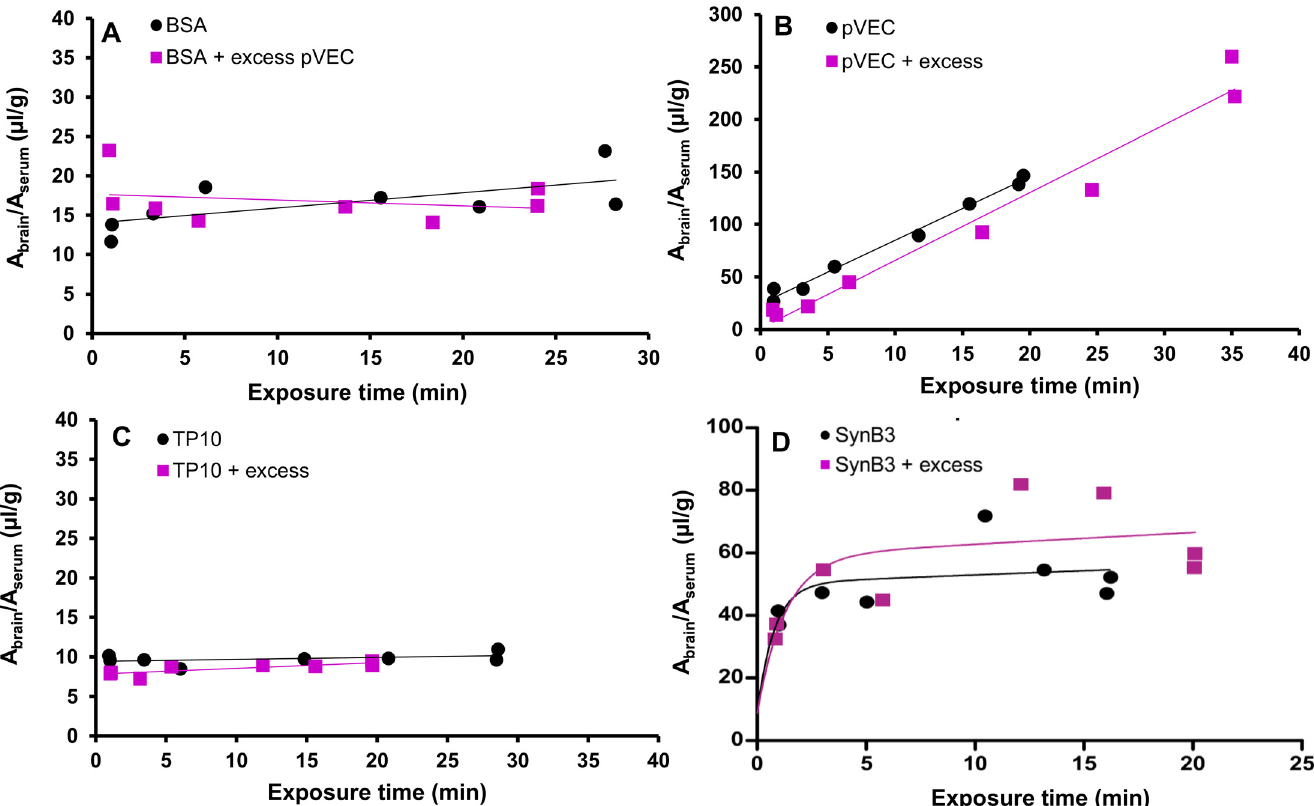
Fig 3. Evaluation of the BBB permeability after injection of pVEC and used brain influx mechanism of pVEC, TP10 and SynB3. (A) Evaluation of the BBB permeability after IV injection of pVEC: ratio of brain-to-serum radioactivity versus exposure time of radioiodinated BSA with (purple squares) and without (black dots) an excess dose of pVEC (20 μ g). (B-D) Evaluation of the saturability of the BBB influx mechanism of pVEC, TP10 and SynB3, respectively: ratio of brain-to-serum radioactivity versus exposure time with (purple squares) and without (black dots) an excess dose of the CPP (10 μ g). Data are fitted using the linear Gjedde-Patlak model, except for the data of SynB3, which are fitted using the biphasic